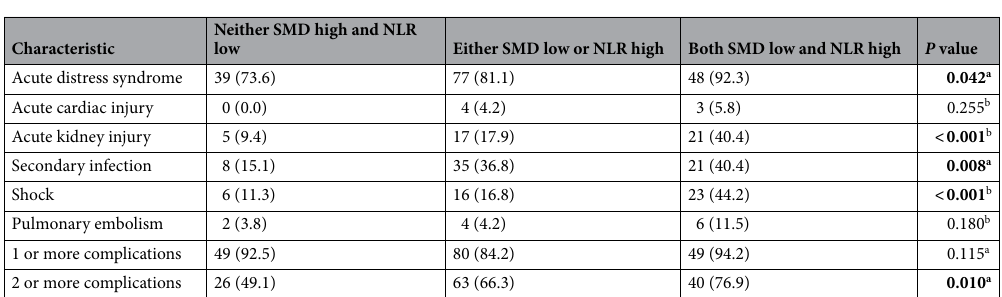
Table 3. Selected COVID-19 complications according to skeletal muscle radiodensity (SMD) and neutrophil- to-lymphocyte ratio (NLR) composite score of patients with COVID-19. a chi-square test. b Fisher’s exact test. Bold indicates P value is statistcally